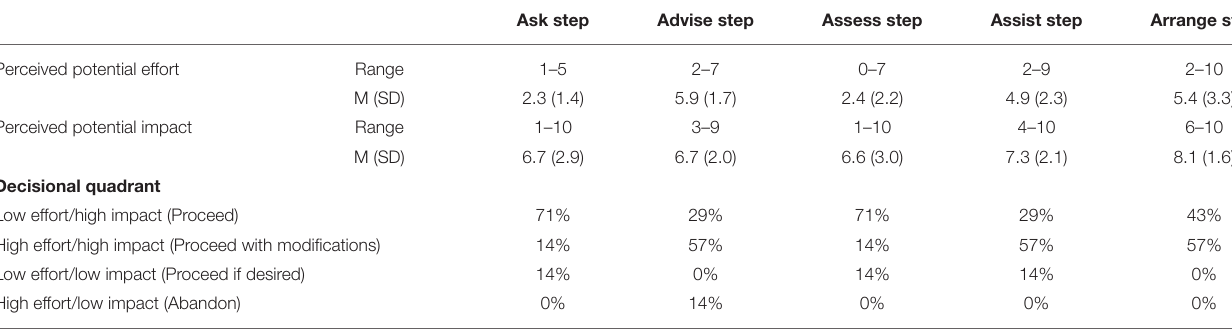
TABLE 1 | Leaders’ perceived potential effort and impact of integrating the 5 A’s into the EHR.